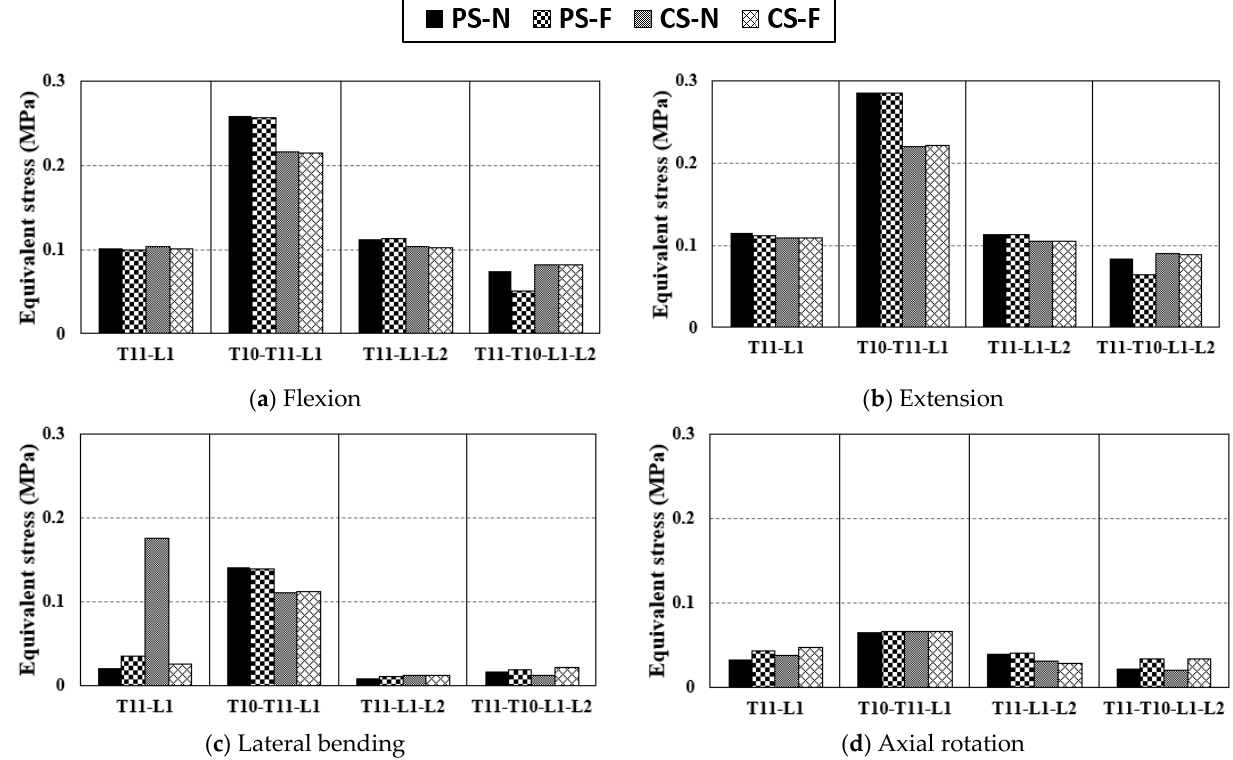
Figure 8. Equivalent stress applied to IVD via pure moment: ( a ) equivalent stress of IVD in flexion, ( b ) equivalent stress of IVD in extension, ( c ) equivalent stress of IVD in lateral bending, and ( d ) equivalent stress of IVD in axial rotation.